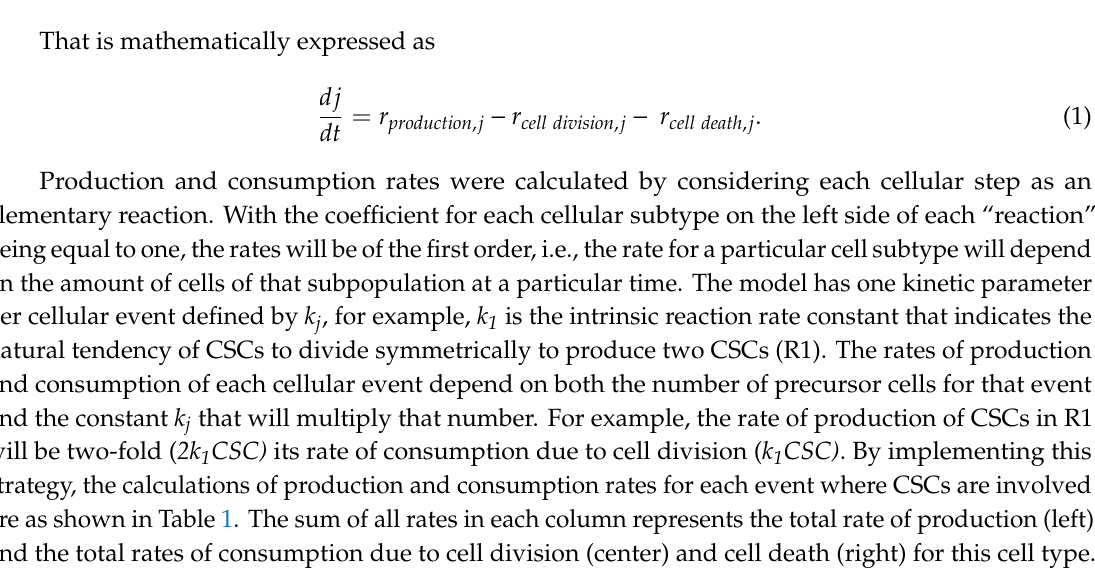
Table 1. Summary of the rates of consumption and production of